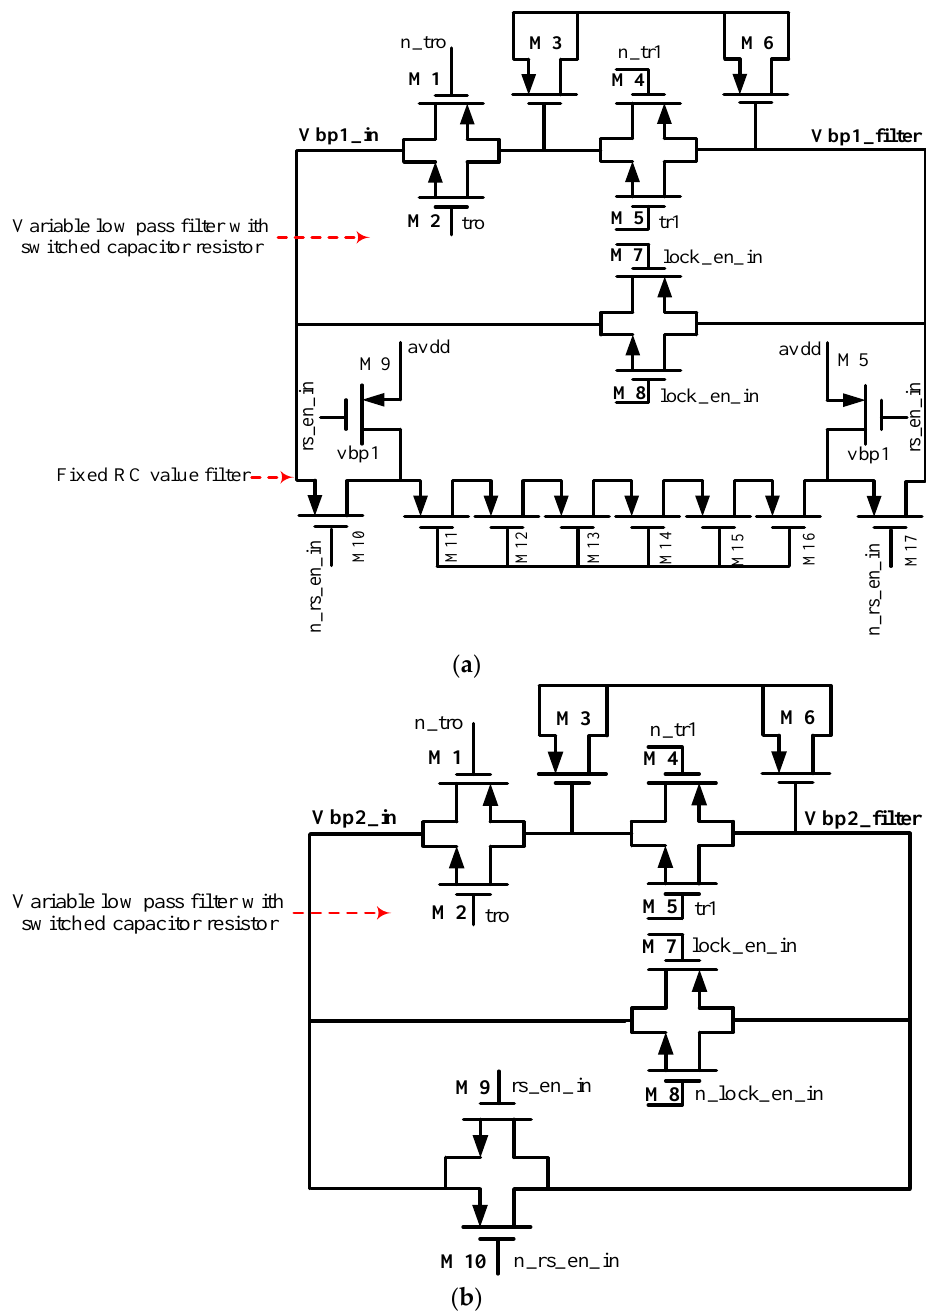
Figure 11. ( a ) Variable low-pass filter for current source; ( b ) variable low-pass filter for cascode devices.